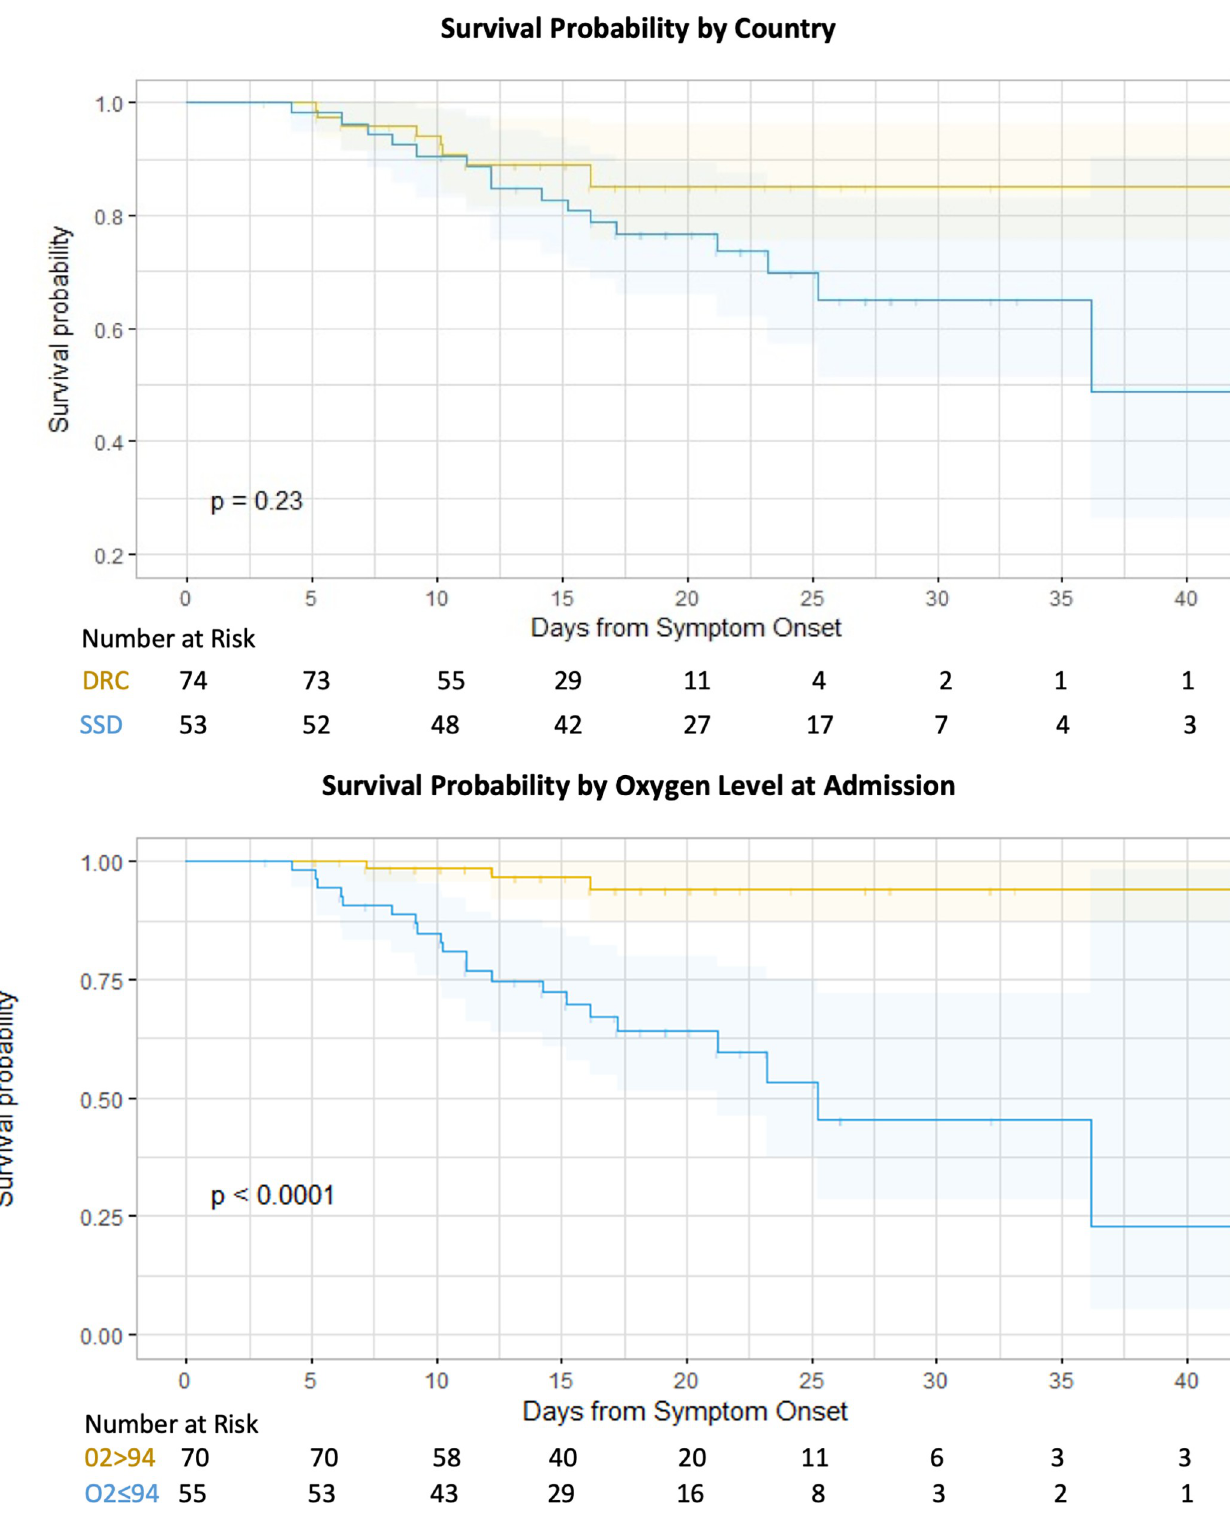
Fig 2. Survival probability by country and oxygen level at admission.